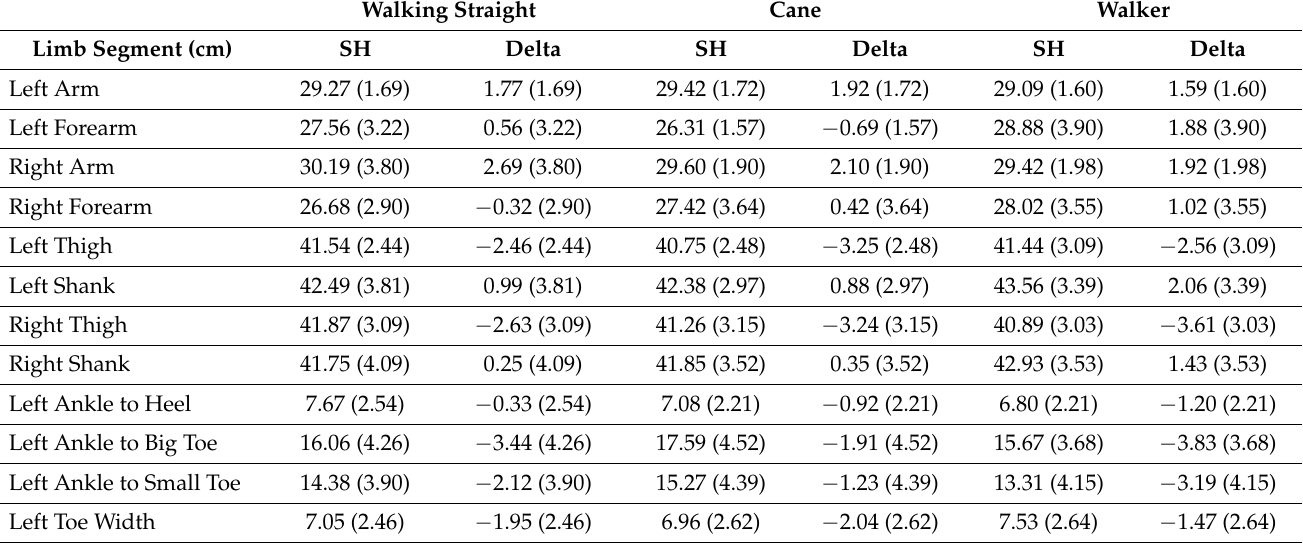
Table A6. Body-segment lengths for participant two: walking-straight, cane, and walker test conditions (mean and standard deviation in brackets). Smart Hallway (SH) is calculated using the 3D reconstructed data, and Delta is the difference between the Smart Hallway and ground-truth segment